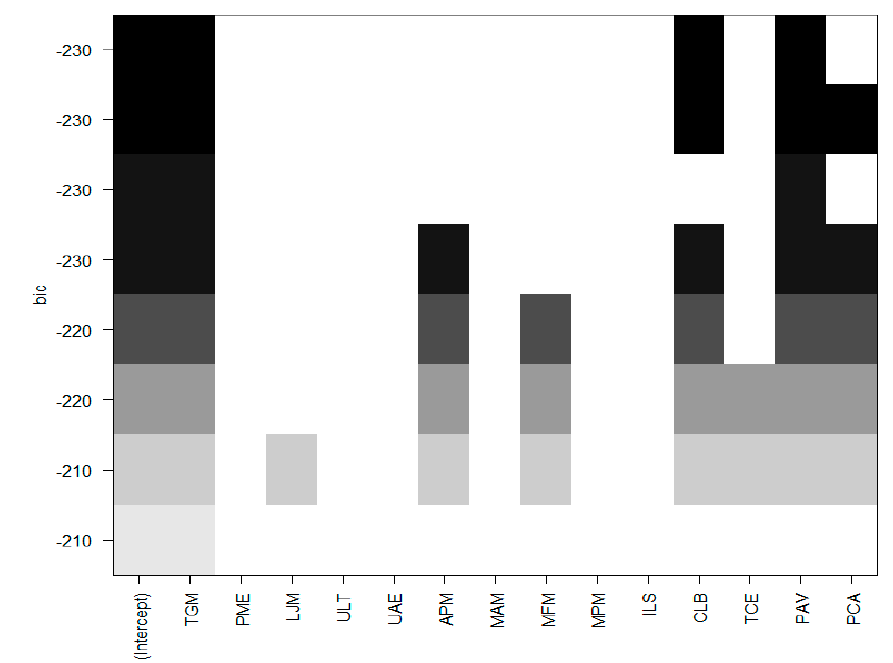
Figure 2. Optimum regression model using sequential replacements.